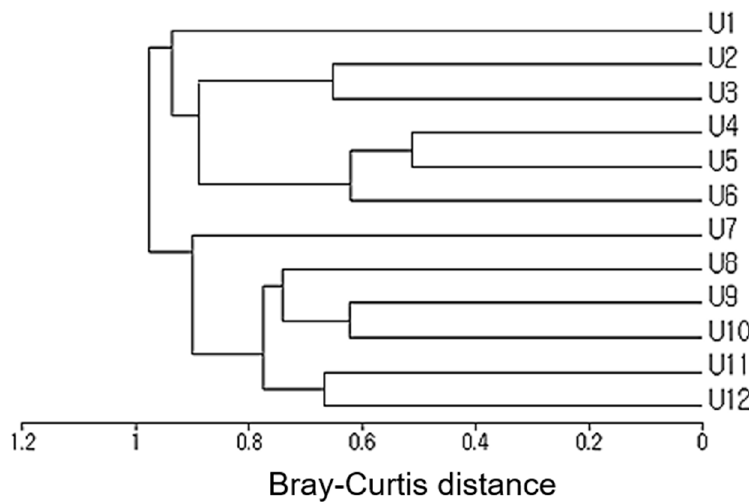
Figure 10. Dendrogram of the phytoplankton communities of 10 sampling sites in the Taehwa River estuary, Korea.